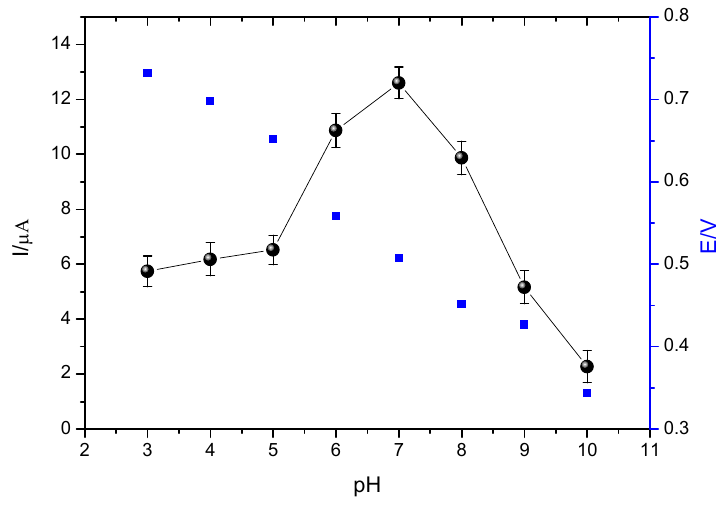
Figure 12. Influence of pH on current variation (ΔI) of the sensor. Concentration of 175 μmol L −1 of Ethinyl estradiol. Measurements made in 0.1 mol L −1 solution of phosphate buffer.